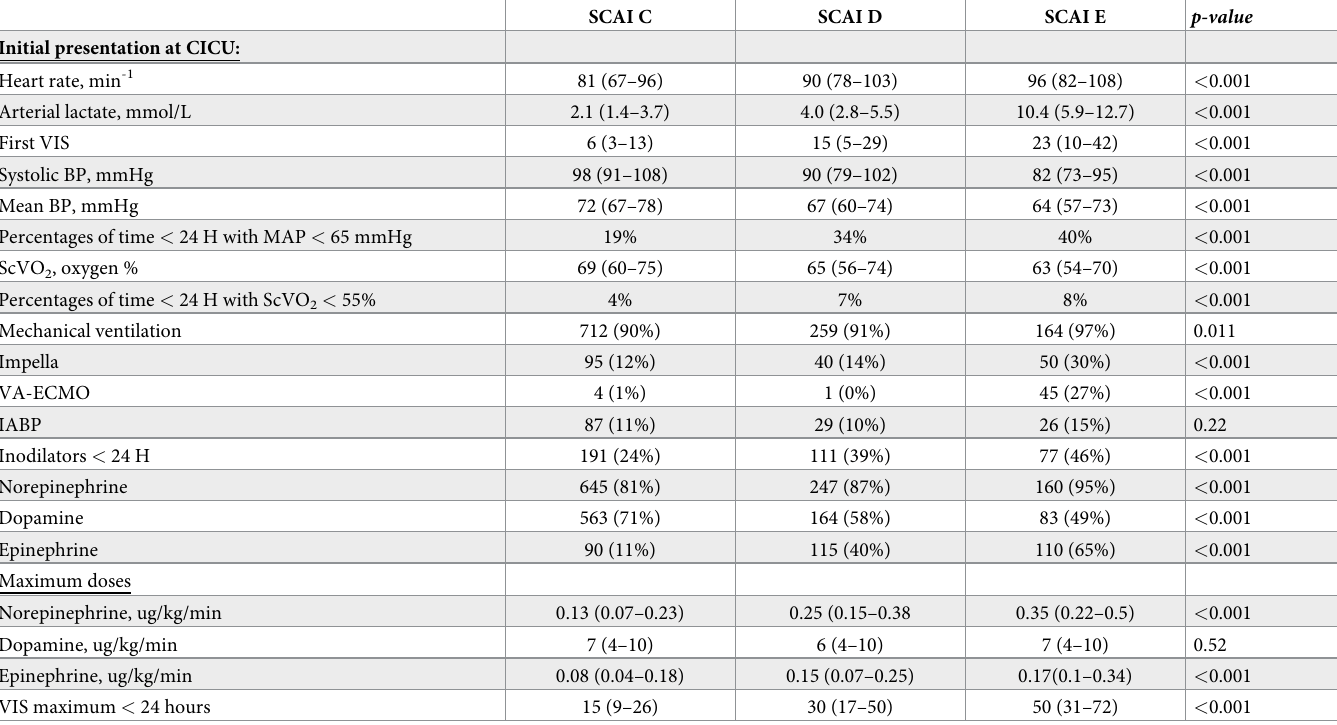
Table 3. Findings at CICU and support during CICU course.